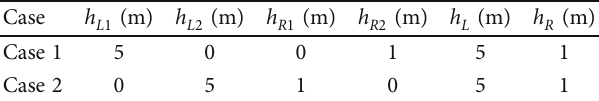
Figure 2: Initial condition of the two-layer dam-break fl ow. Table 1: Initial conditions of the dam-break fl